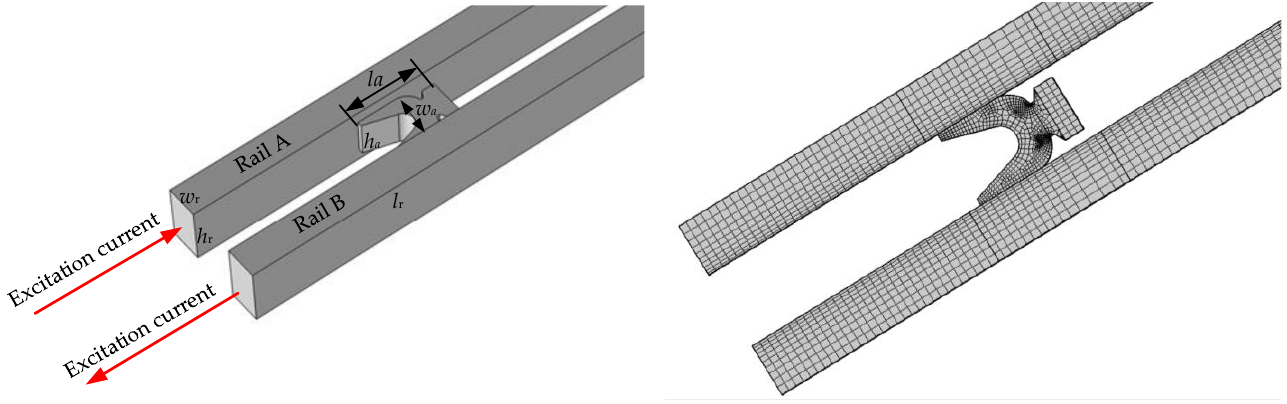
Figure 1. Electromagnetic railgun geometric model and the mesh segmentation result.